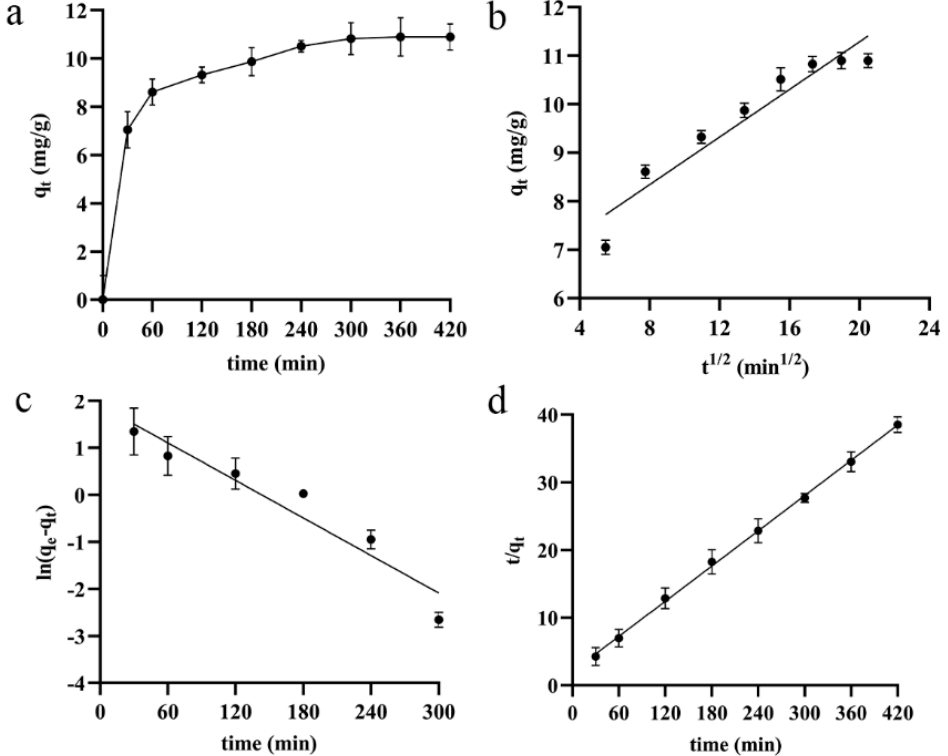
Figure 5. D101 static adsorption kinetic curve of macroporous resin ( a ); intra-particle diffusion ( b ); pseudo-first-order ( c ); pseudo-second-order ( d ).